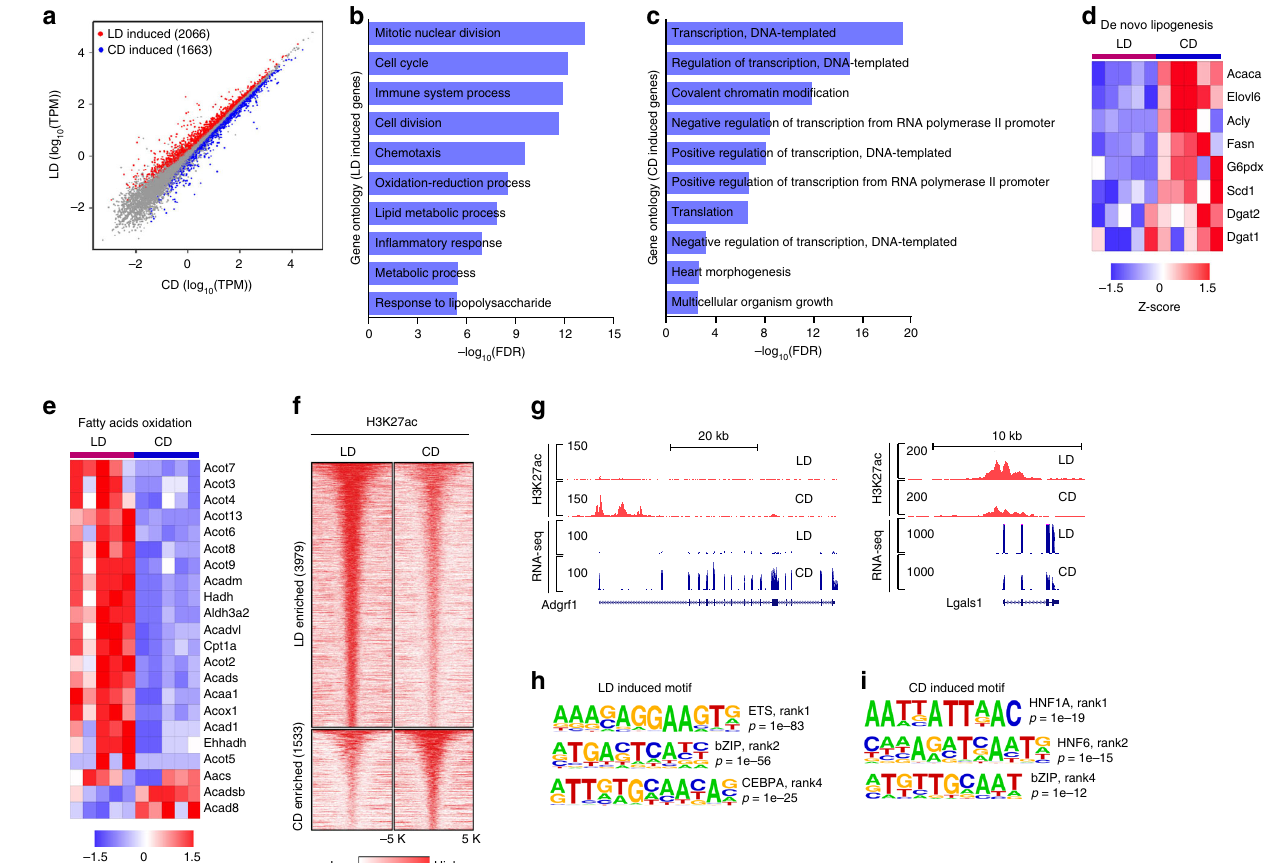
Fig. 2 Chronic obesity reprograms the liver transcriptome and enhancer network. a Scatter plot of RNA-seq data in mice on CD or LD. Upregulated transcripts are those higher in LD (LD induced). Downregulated transcripts are those higher in CD (CD induced). b , c Pathway analysis of LD/CD induced genes. d , e Heatmap of key genes involved in de novo lipogenesis or in fatty acid oxidation. Each column contains data from an individual study animal, each row represents a gene. f Heatmap of H3K27ac differentially enriched regions in LD and CD ( n = 3 per group). Each row in the heatmap represents an individual differentially acetylated locus. LD induced loci represent loci with higher acetylation status in lipid-rich diet. CD induced loci represent loci with higher acetylation status in CD condition. g Example of an H3K27ac differentially enriched region. Left panel depicts the Adgrf1 locus which has higher acetylation and transcript levels on CD. Right panel depicts the Lgals locus which has higher acetylation and transcript levels on LD. h , i Motifs enriched in LD or CD induced H3K27ac differentially enriched regions. ∗∗∗∗ p <